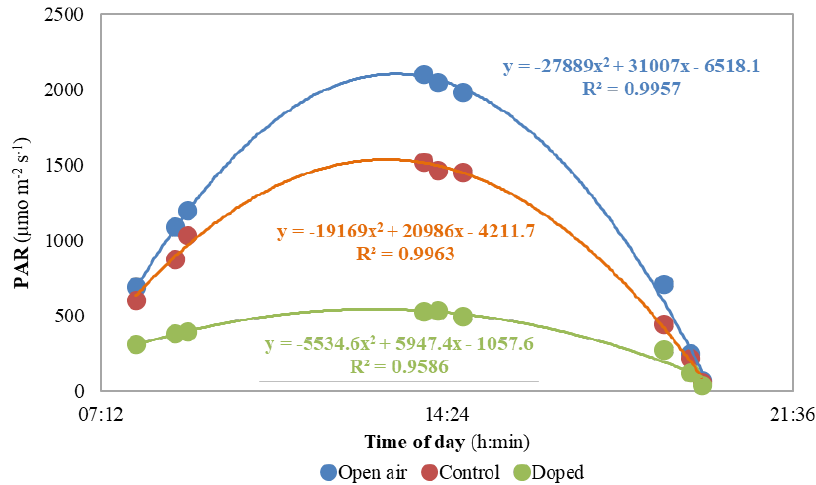
Figure 3. Photosynthetically active radiation (PAR) intensity during the day inside doped and control greenhouses and in open air.